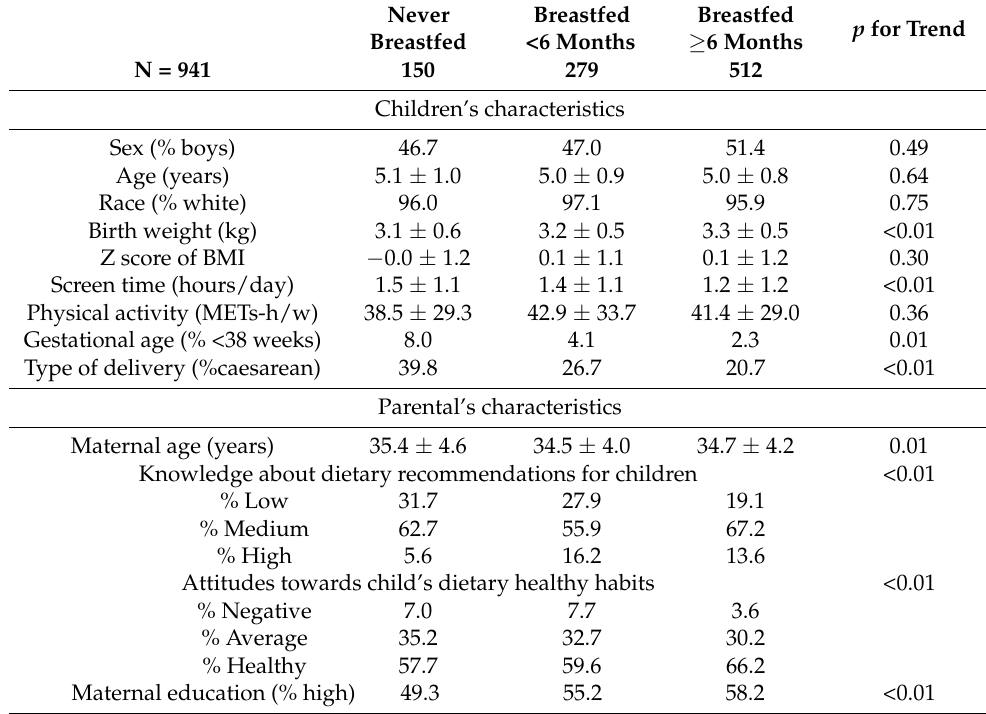
Table 1. Demographic and Basal characteristics of study participants according to breastfeeding. The SENDO project.